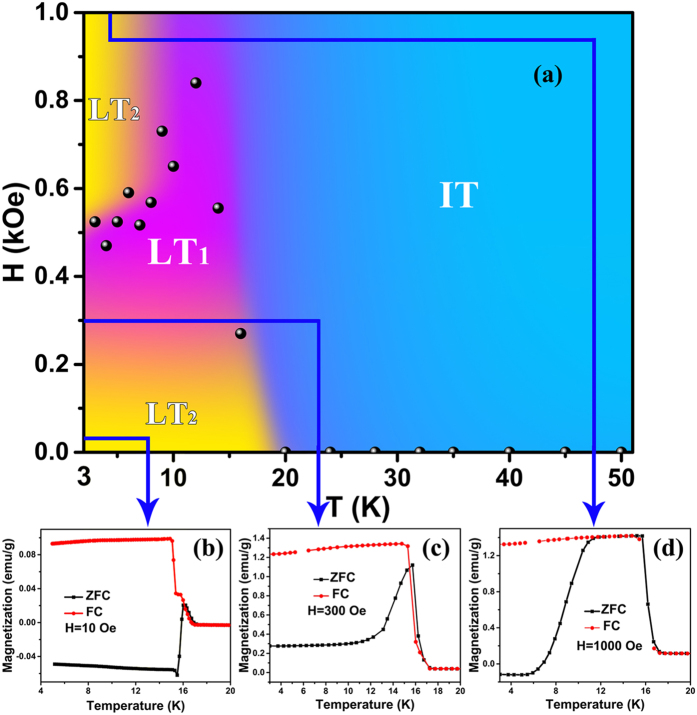
The phase diagram of magnetization vectors of TbFe1−xMnxO3 (x = 0.25) by tuning the applied magnetic field and temperature.LT1: low temperature phase-1, LT2: low temperature phase-2, IT: intermediate temperature phase.